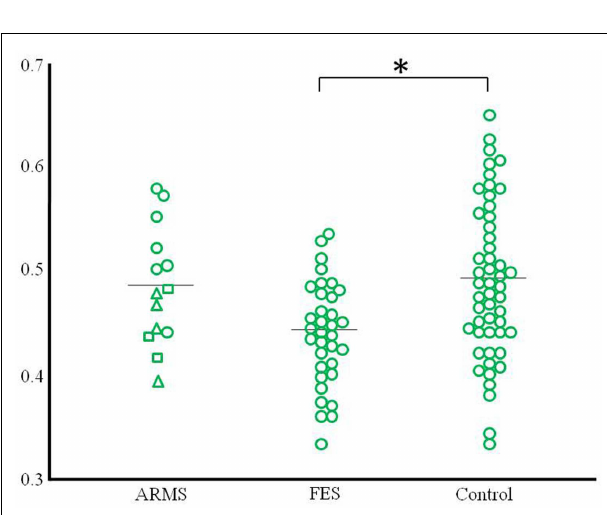
FIGURE 2 | Scatter plots of gray matter volume of the peak coordinate at the left anterior cingulate gyrus that revealed the difference between schizophrenia patients and controls. The ARMS subjects were classified into three groups according to clinical outcome (square: ARMS who developed psychosis, triangle: ARMS with unknown outcome, circle: ARMS without transition to psychosis). * p < 0.05.